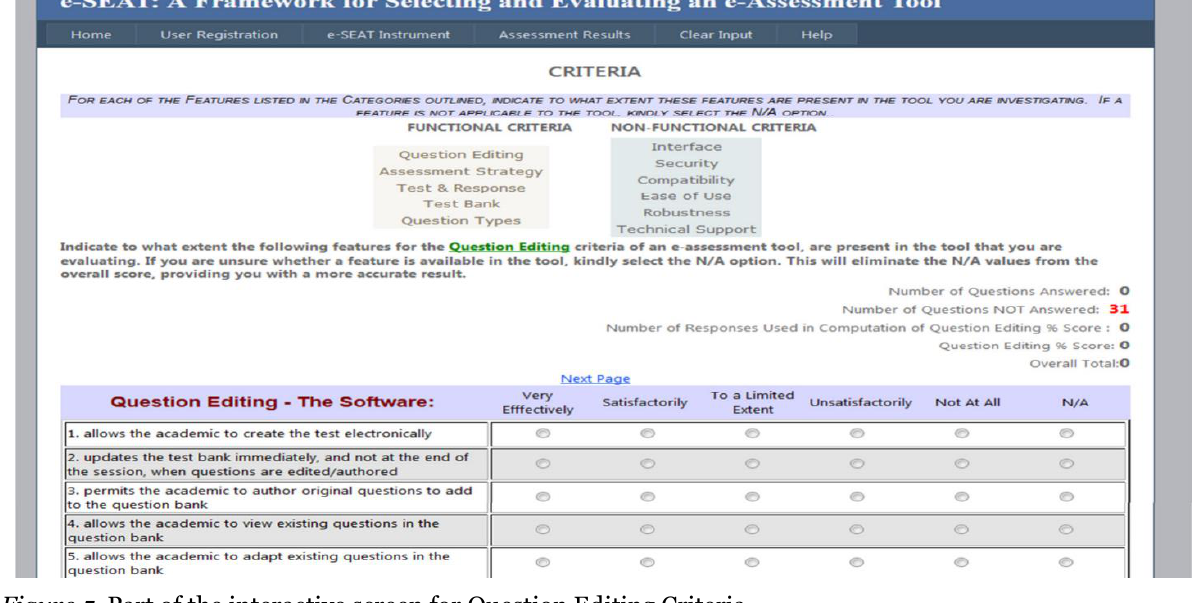
Figure 5. Part of the interactive screen for Question Editing Criteria. Table 3 lists the Functional Criteria and Table 4 the Non-Functional Criteria of the e-SEAT Instrument.